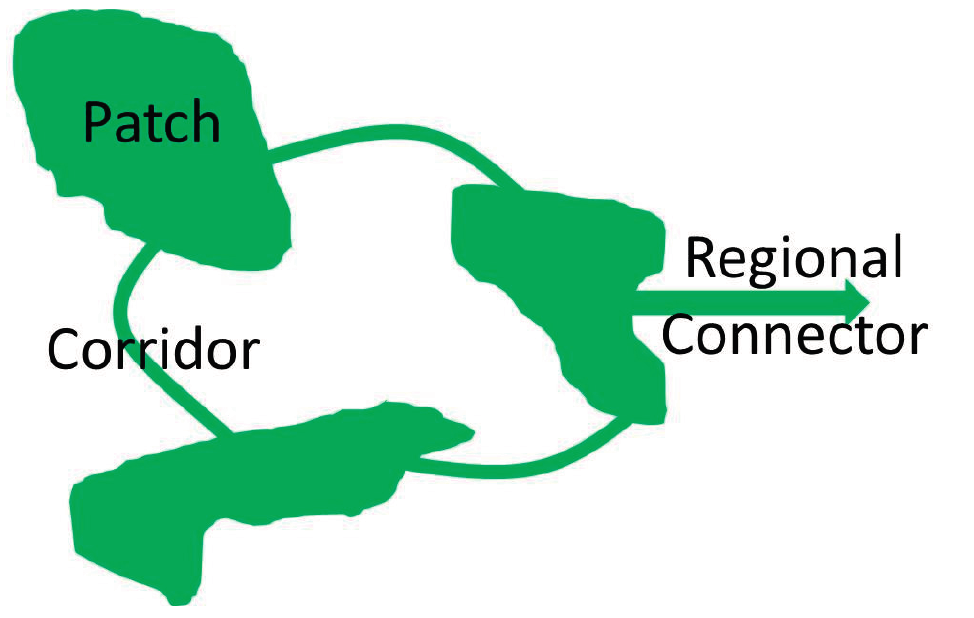
Figure 2. Green infrastructure.